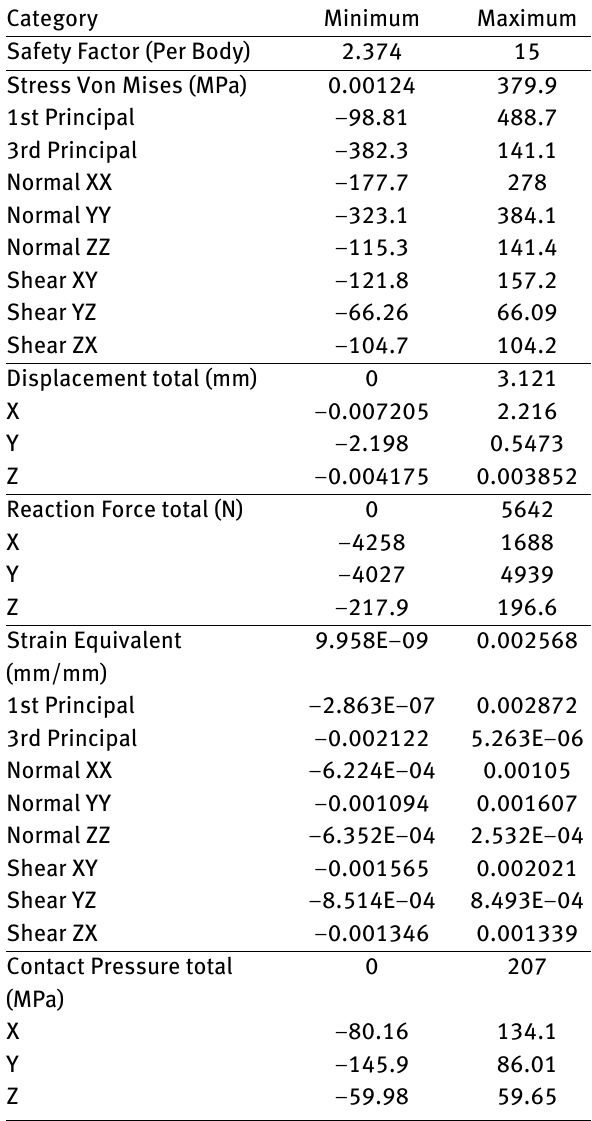
Table 4: Full result summary of 0.25 m by 6000 N loaded